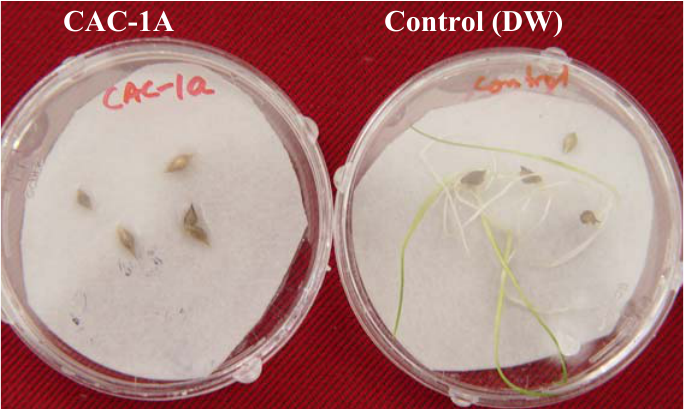
Figure 4. Effect of compound 1 on the growth of EC seeds ( n =